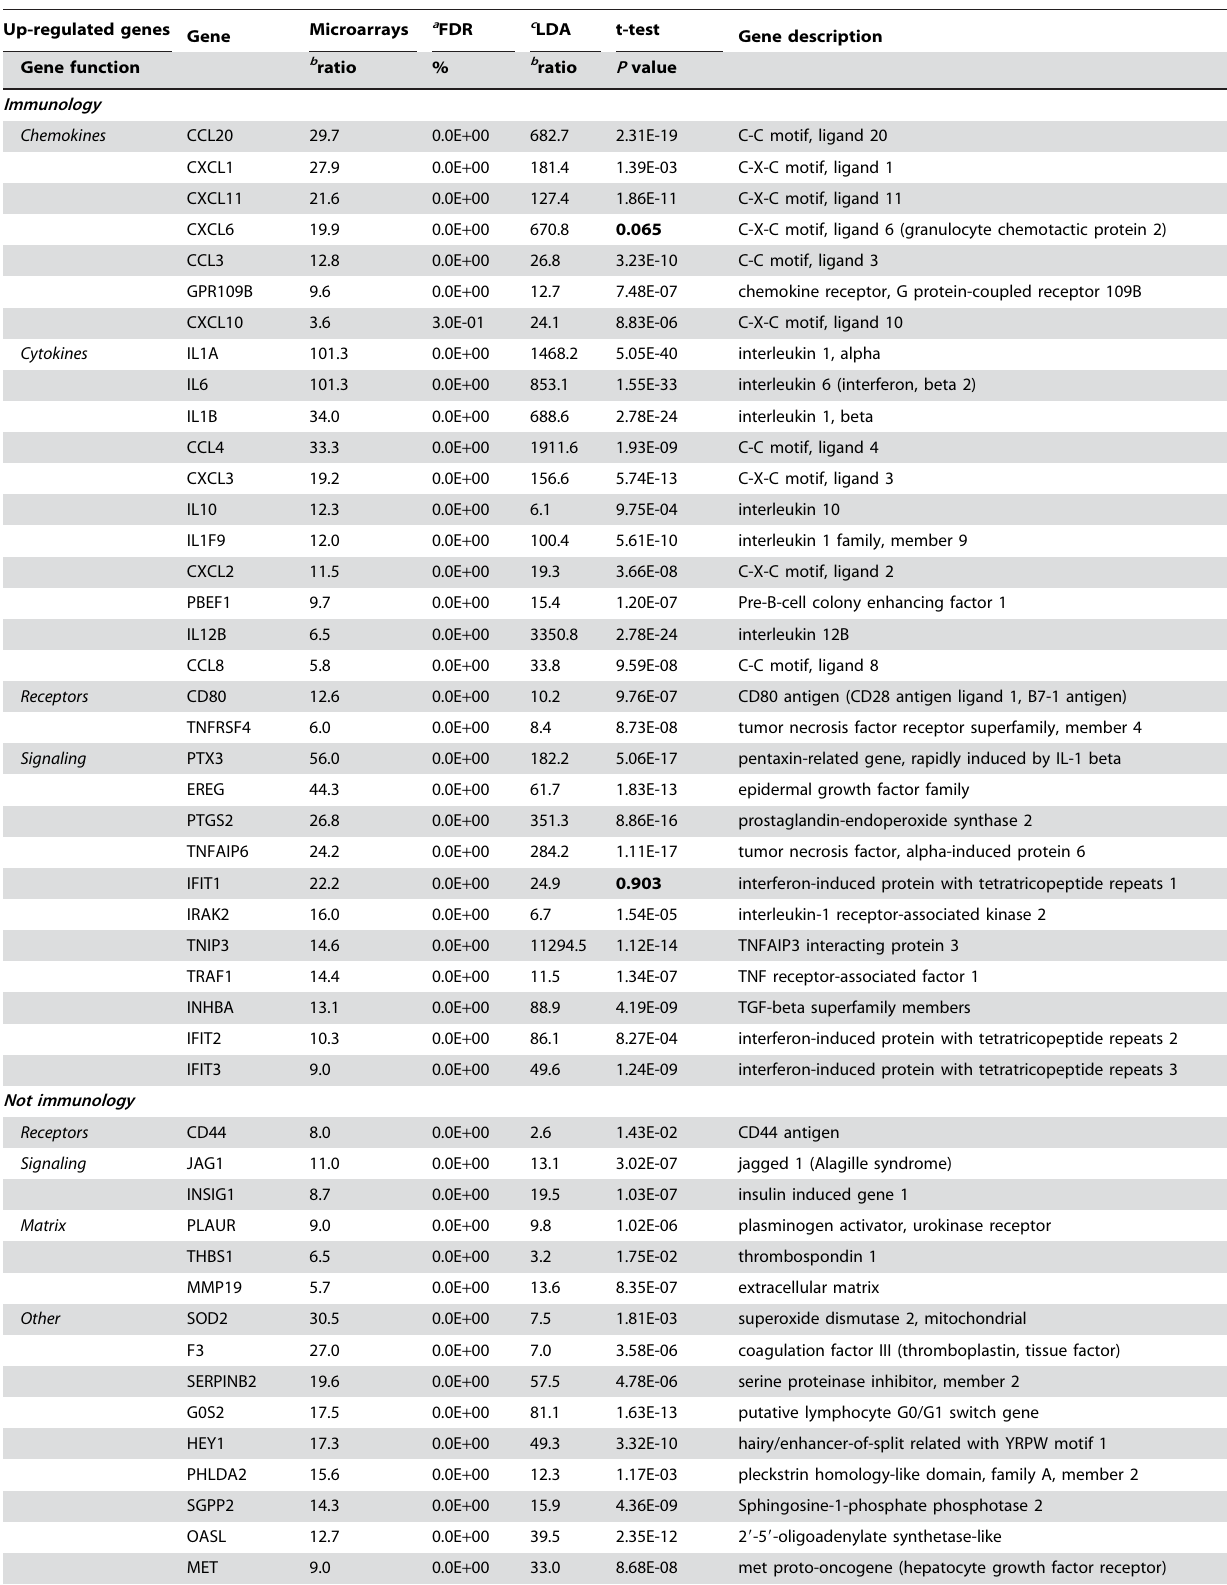
Table 3. Validation results of Mtb stimulated macrophage gene expression of 58 genes in 34